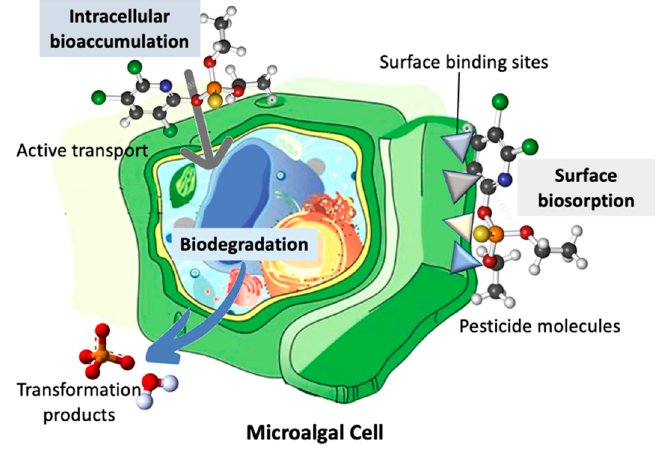
Figure 2. Schematic illustration of phytoremediation of pesticides by microalgae through biosorption, bioaccumulation and biodegradation.